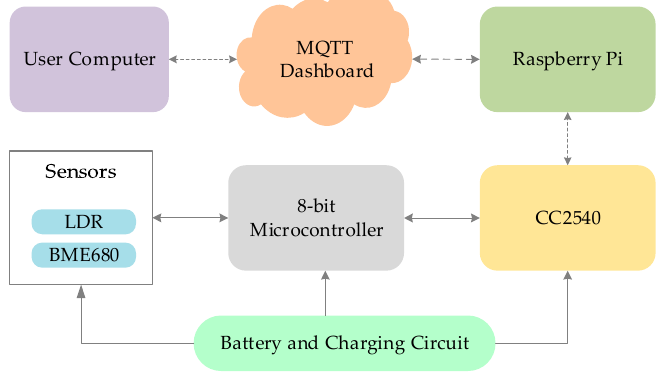
Figure 9. System Architecture for Indoor Environmental Monitoring.